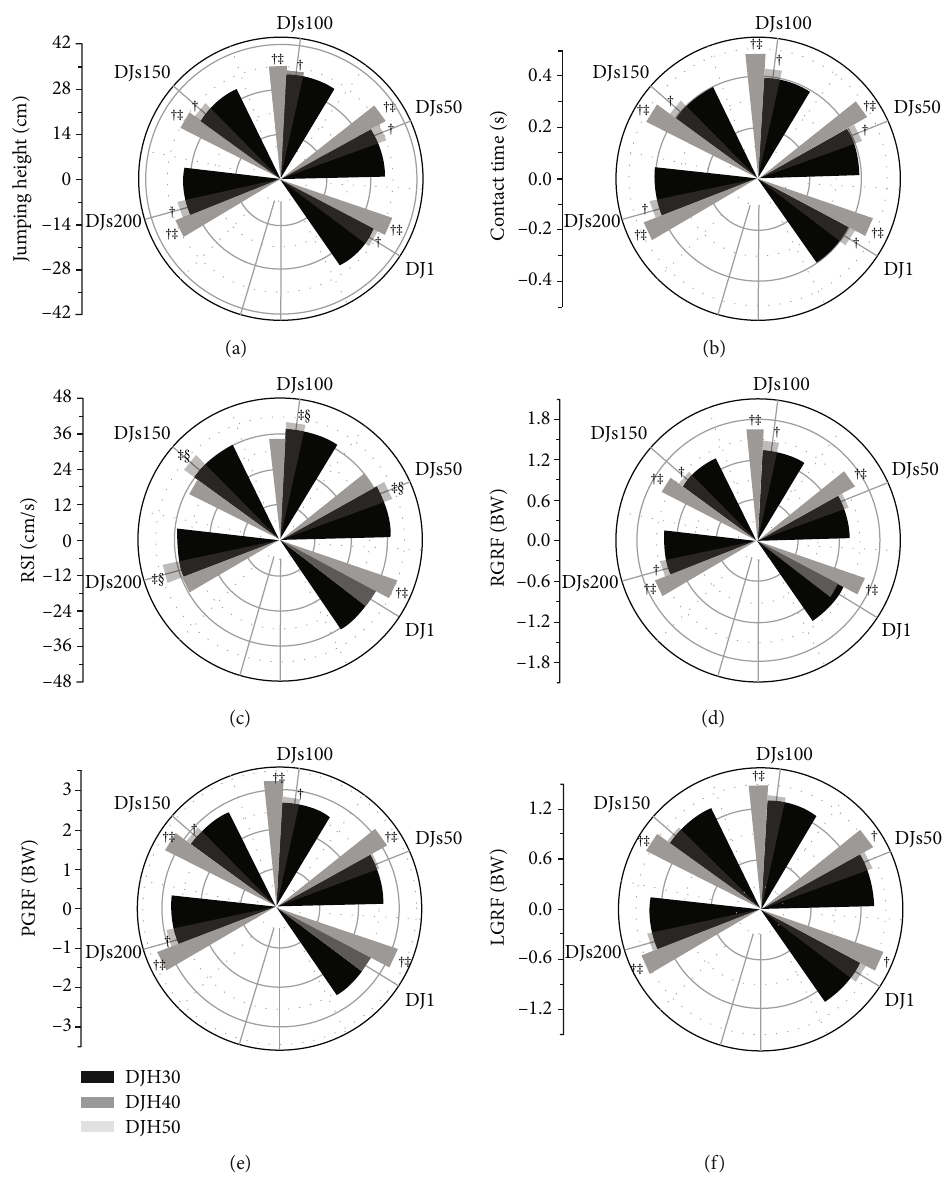
Figure 2: The jumping height, contact time, reaction strength index, the peak vertical GRF, and right and left leg GRF during drop jumps from three heights at DJ1, DJs50, DJs100, DJs150, and DJs200. Asterisk † indicates that a signi fi cant di ff erence with DJH30; ‡ indicates that a signi fi cant di ff erence with DJH40; § indicates that a signi fi cant di ff erence with DJH50. p values < 0.05 were considered to signi fi cantly di ff